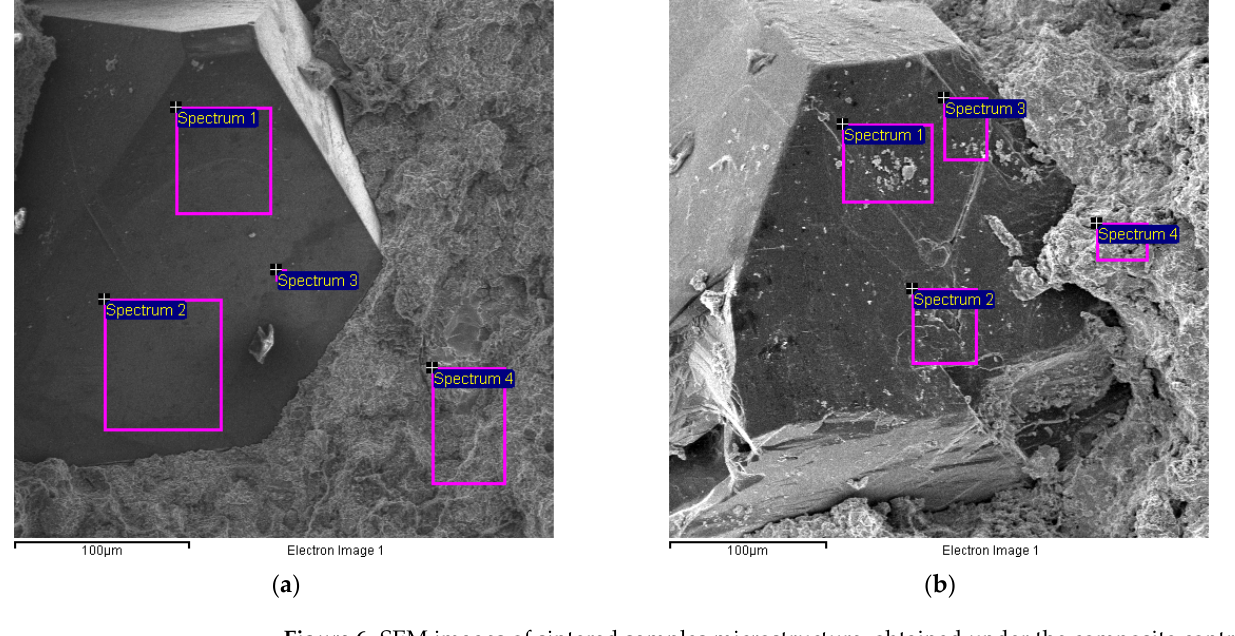
Figure 6. SEM images of sintered samples microstructure, obtained under the composite contrast, showing EDS areas: ( a ) Sample 1; ( b ) Sample 5. Table 4. Results of elemental analysis of different sections of samples 1 and 5, the spectra are specified in Figure 6.